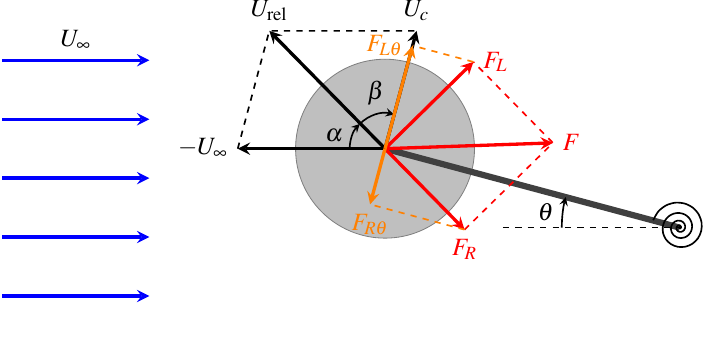
Figure 3. Vector diagram of the hydrodynamic forces acting on a cylinder that performs angular oscillations about the pivot